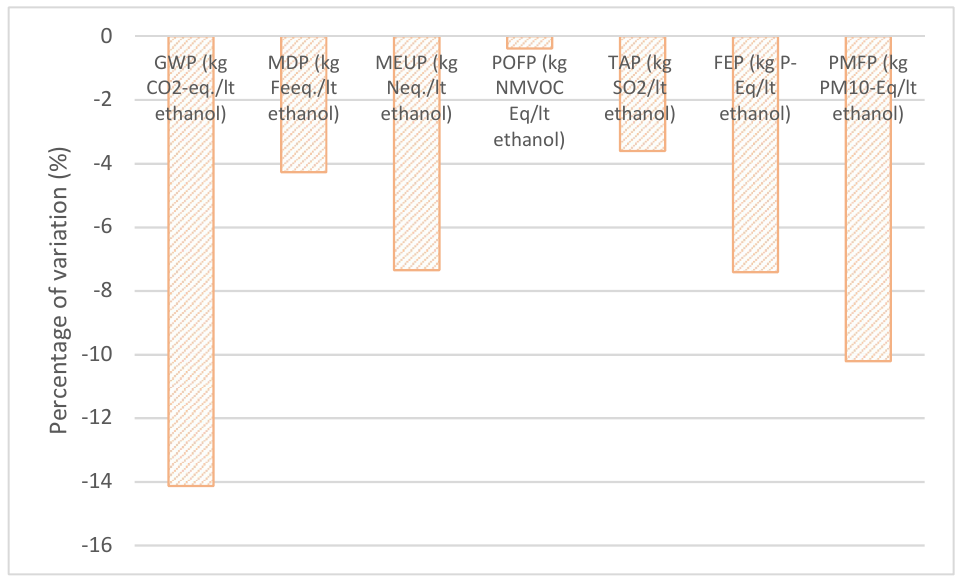
Figure 3. Percentage of variation for each environmental impact indicator result through an increase